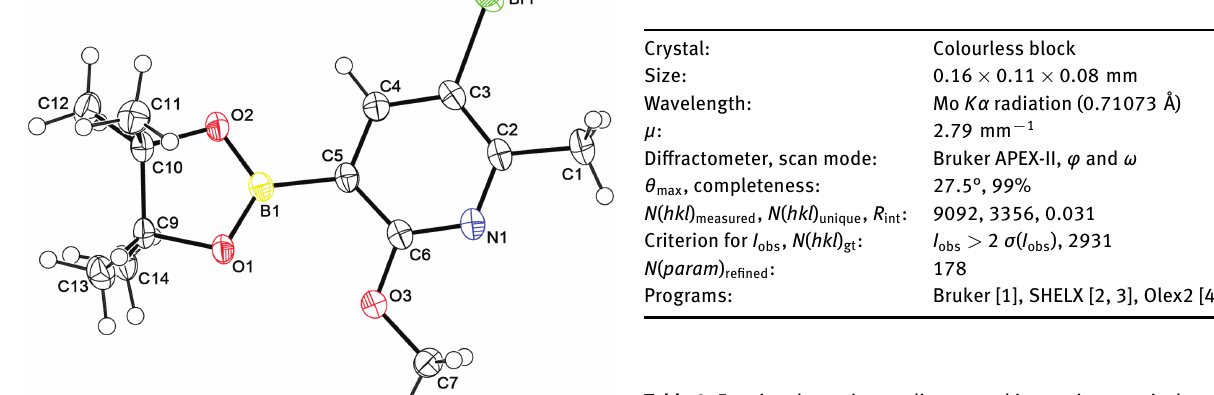
Table 2: Fractional atomic coordinates and isotropic or